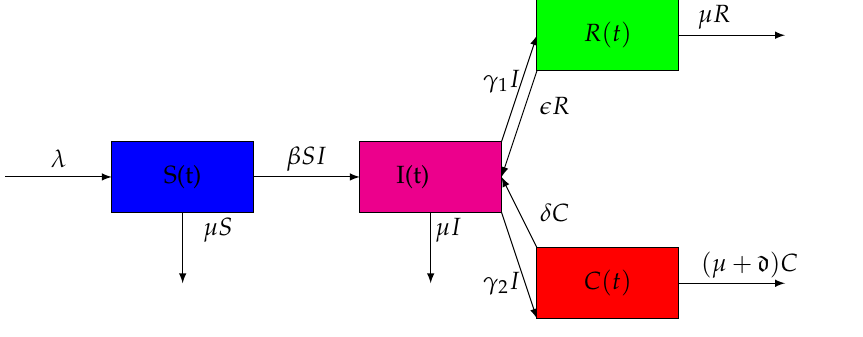
Figure 1. The diagram of the SICR model. Table 1. Parameters and their meanings in the suggested SICR